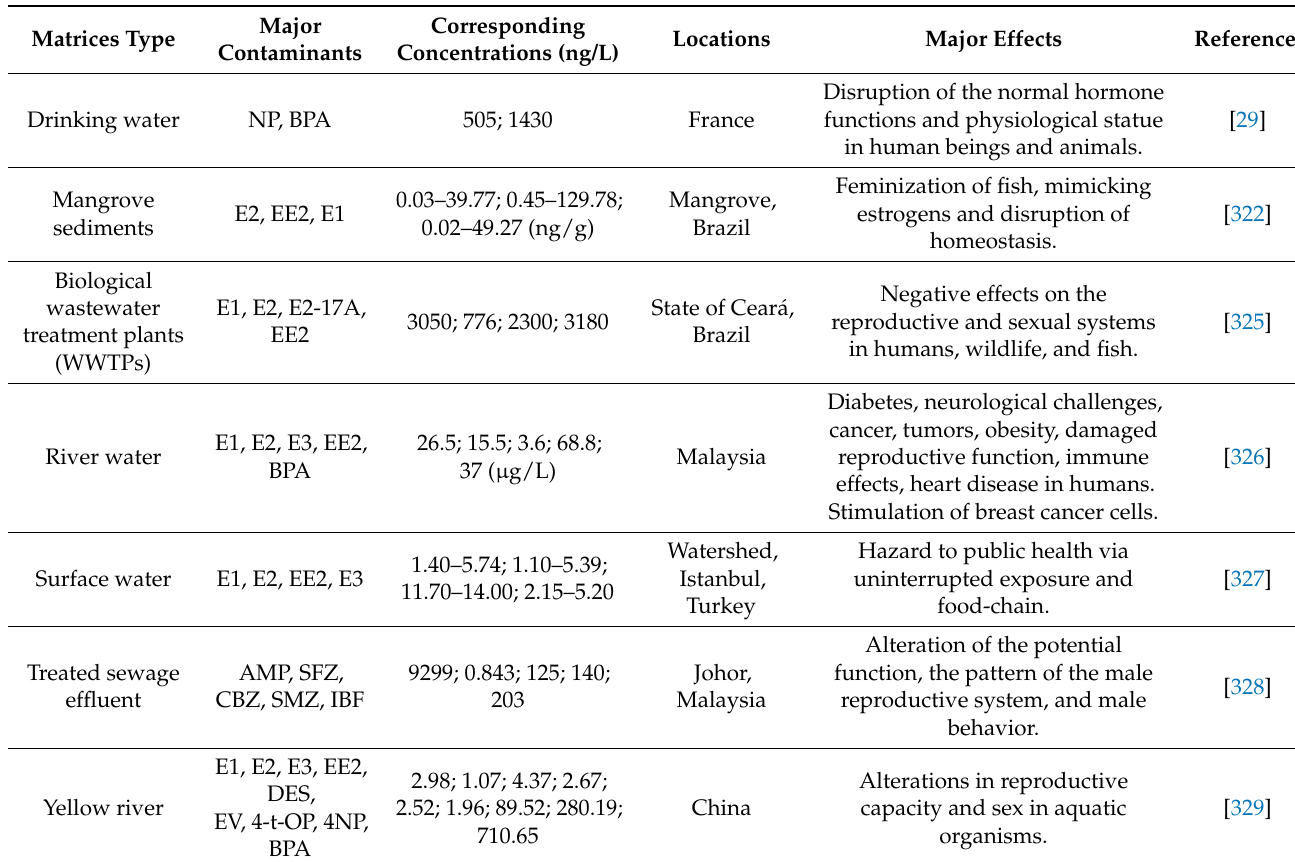
Table 2. Published information from various locations on different proportions and the negative influence of endocrine- disrupting compounds on the